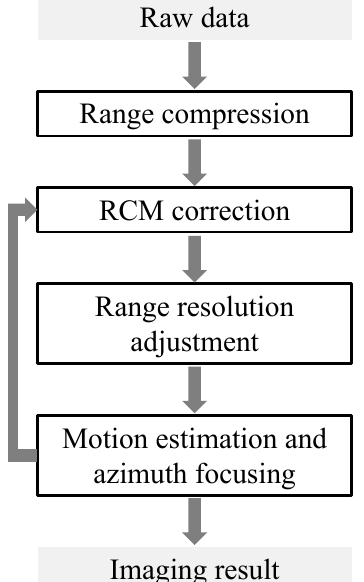
Figure 3. Block diagram of the coarse-to-fine range cell migration (RCM) correction